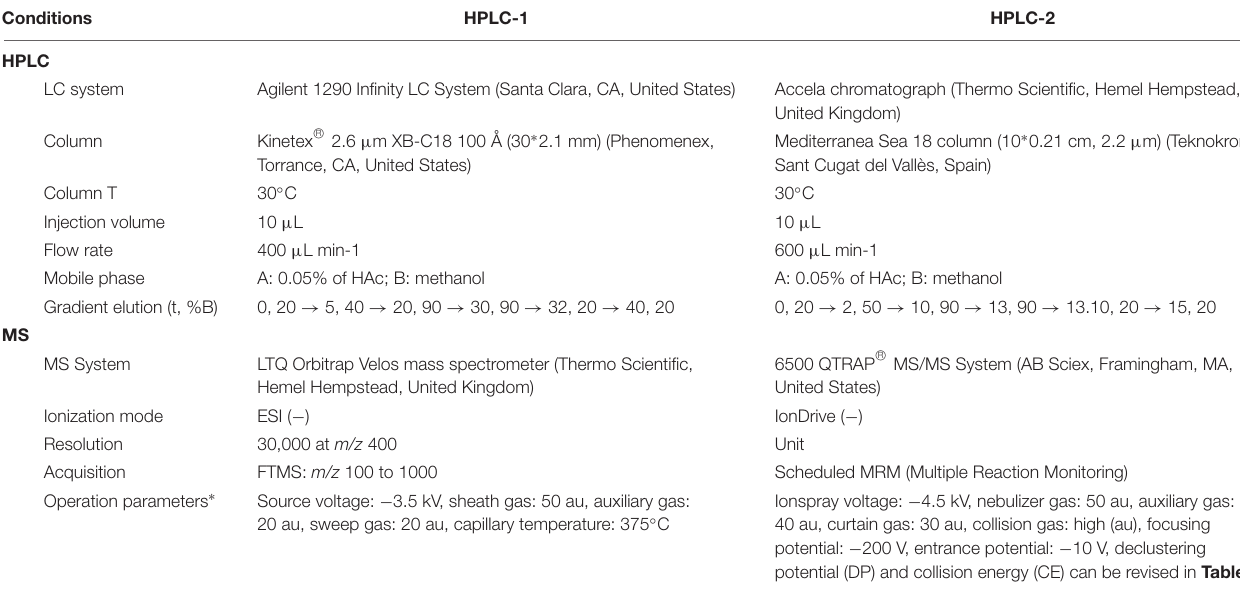
TABLE 2 | HPLC and MS conditions and parameters for HPLC-1 and HPLC-2 methods. Conditions